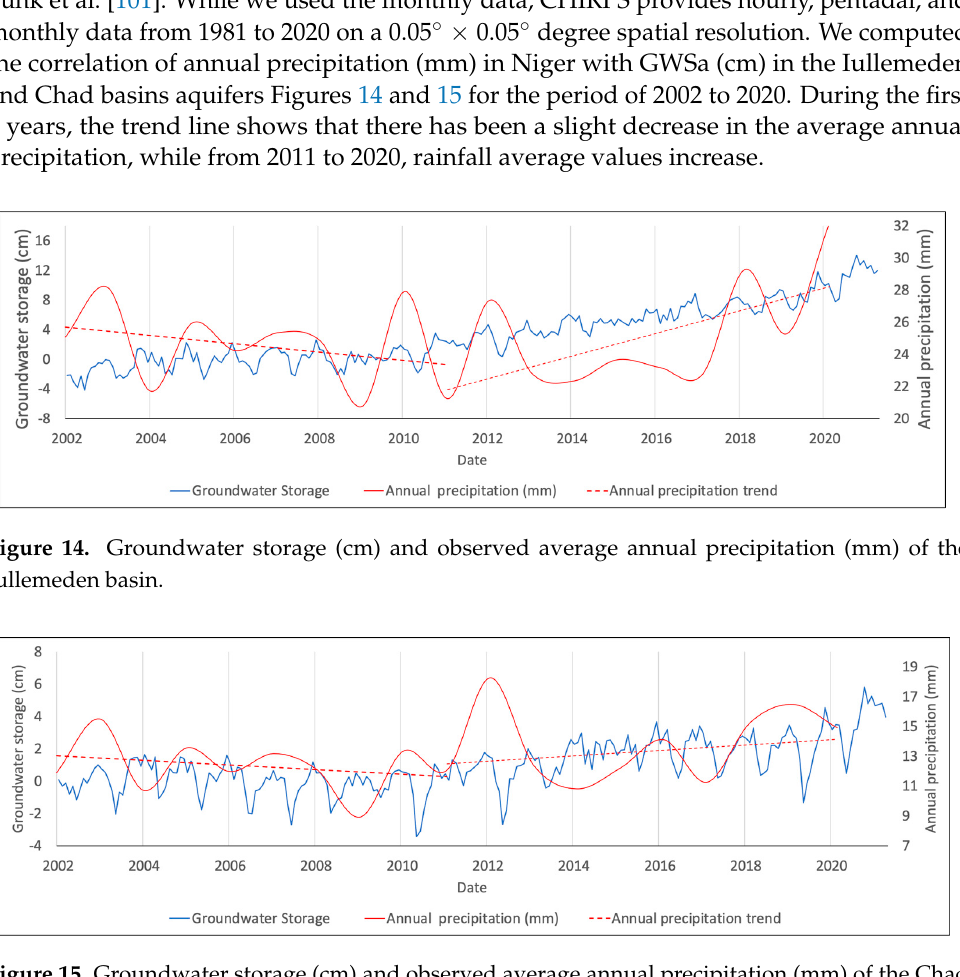
Figure 15. Groundwater storage (cm) and observed average annual precipitation (mm) of the Chad Basin.